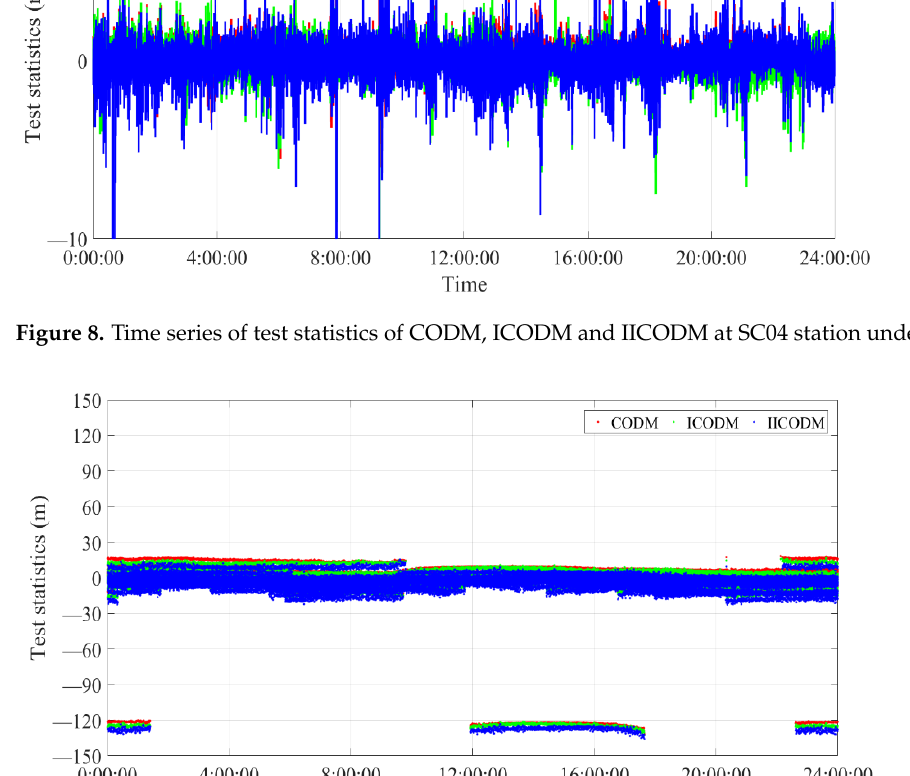
Table 7. The computation time of three methods in two cases (%).